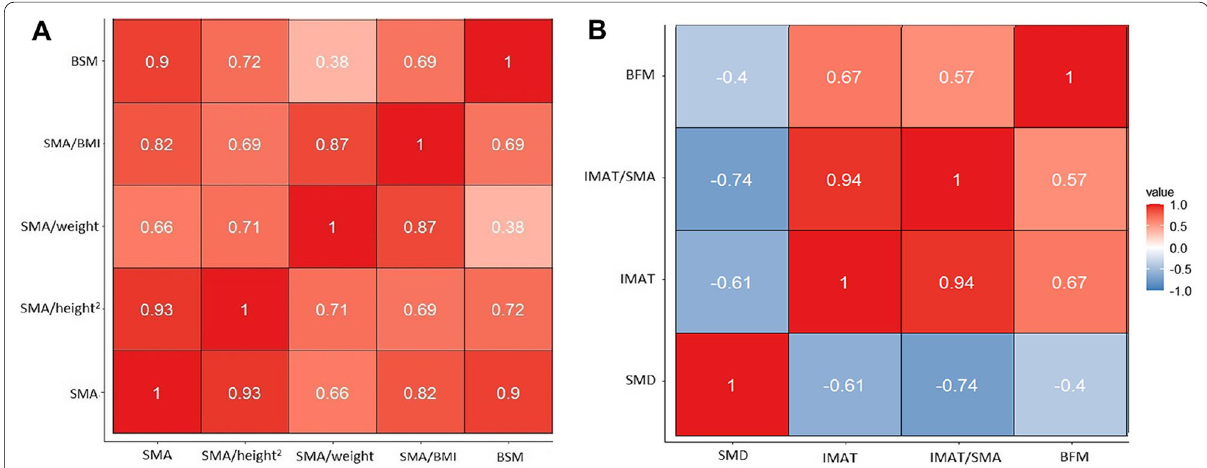
Fig. 3 The correlations (Pearson’s r) of SMA and SMIs measured by CT and BSM measured by BIA ( A ) and the correlations (Spearman’s ρ) of SMD, IMAT, and IMAT/SMA measured by CT and BFM measured by BIA ( B